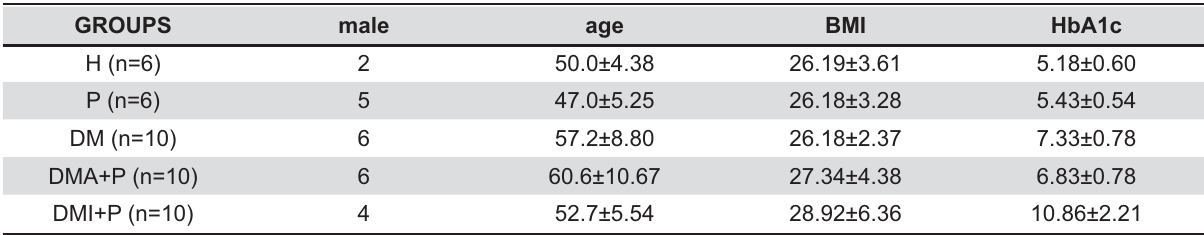
Table 1- Demographic characteristics and glycated level (mean±standard deviation) for participants in each group